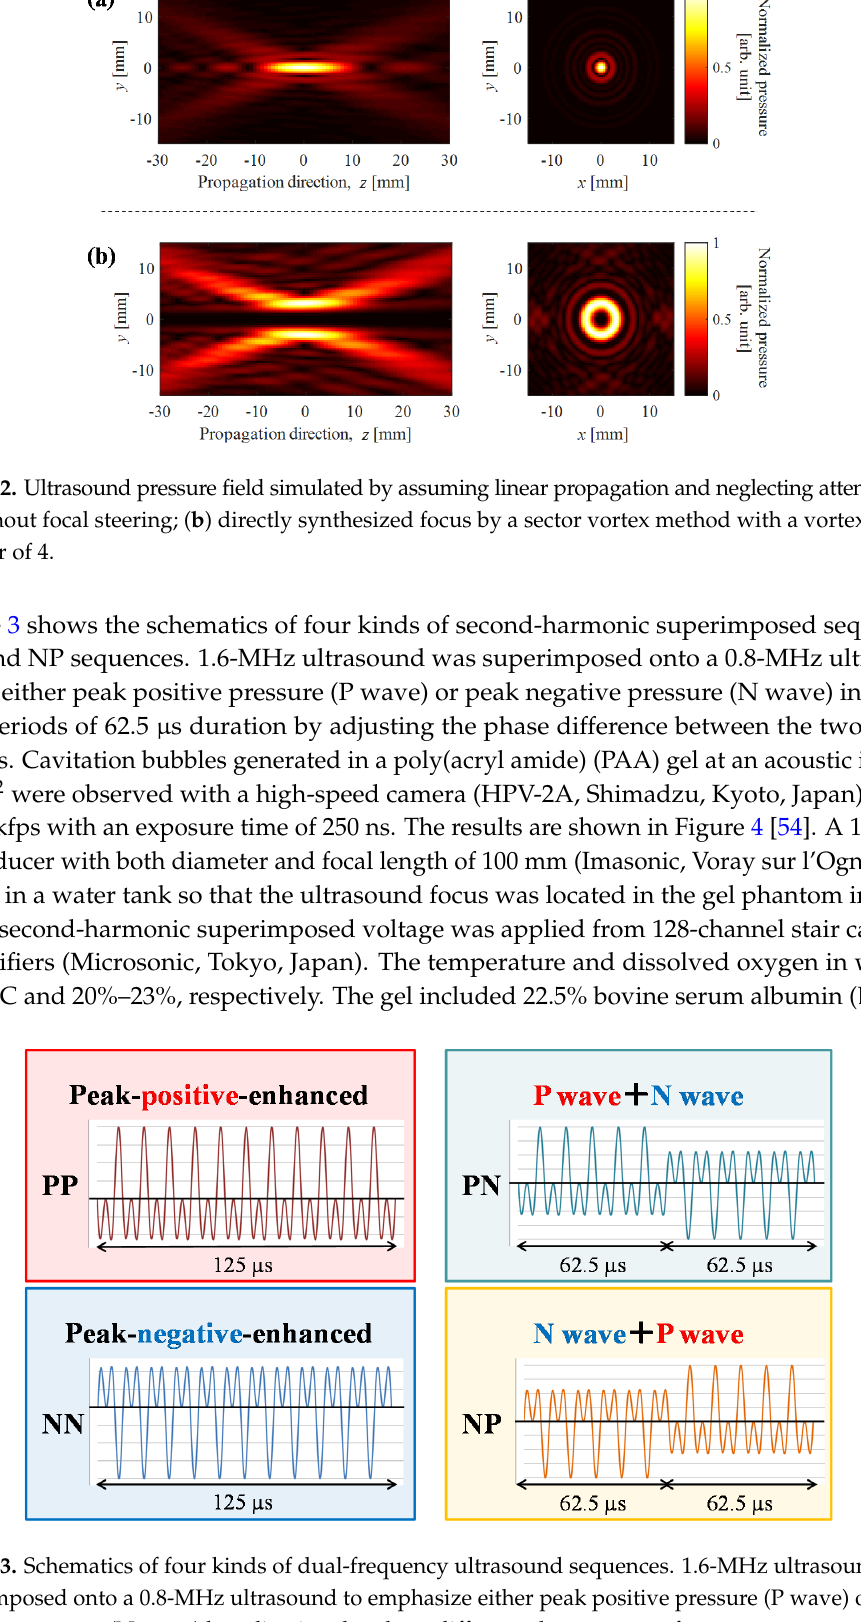
Figure 1. Schematic of three examples of a trigger high-intensity focused ultrasound (HIFU) sequence